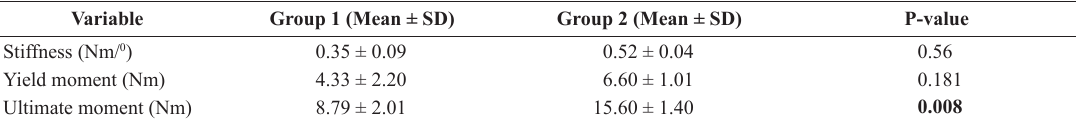
Table 3. Mean values and standard deviation (SD) for each variable evaluated in Groups 1 and 2 under static torsion tests. Variable